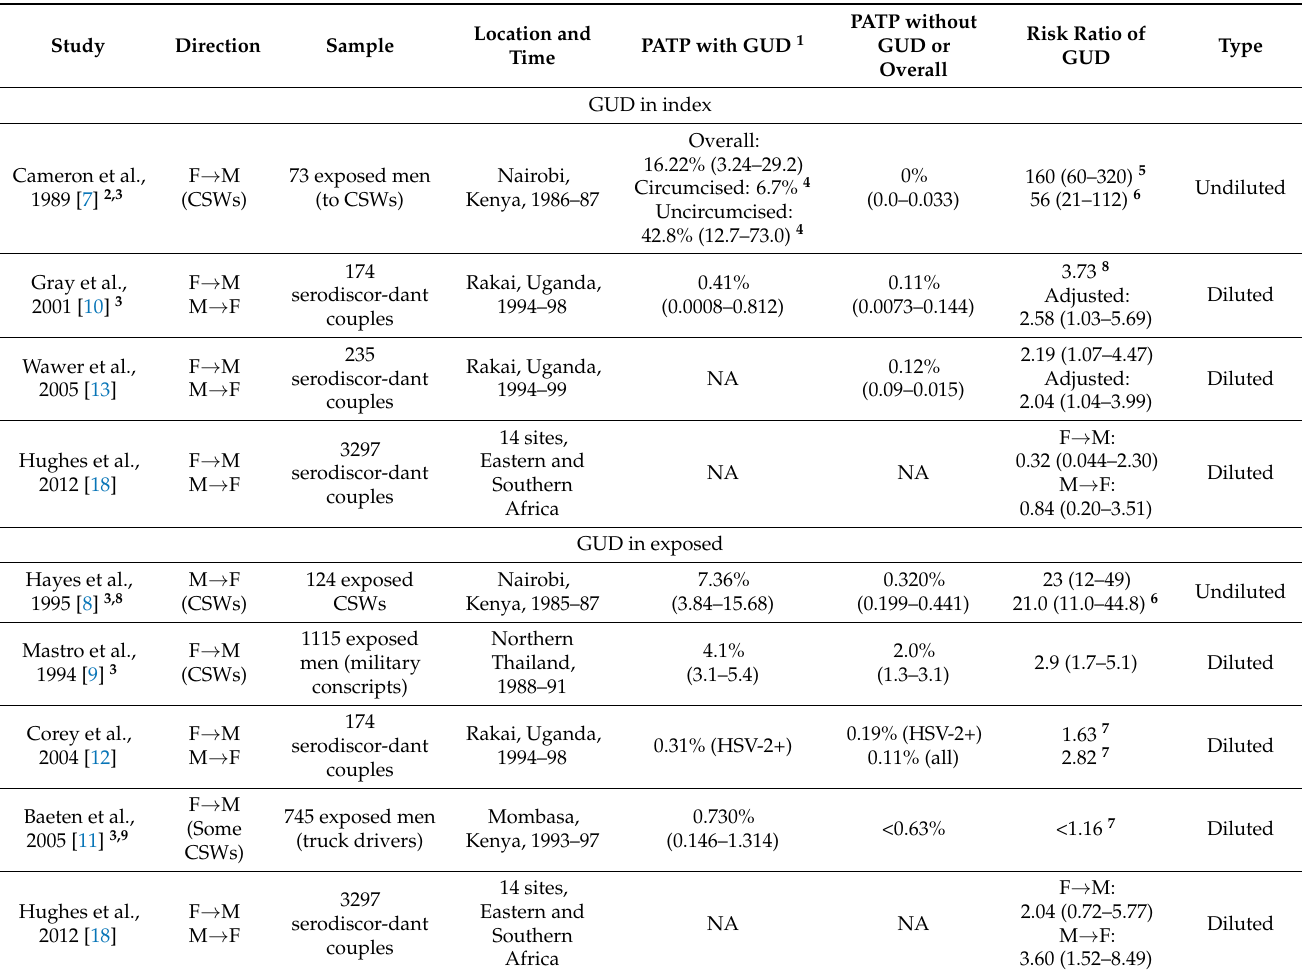
Table 1. The studies that estimated HIV-1 PATPs with GUD present or the risk ratio of GUD over baseline